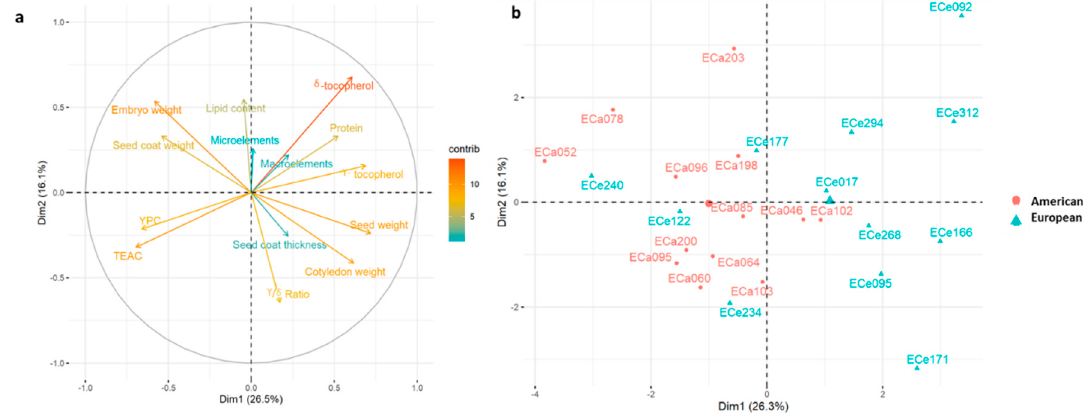
Figure 5. ( a ) Principal component analysis for the 25 American and European accessions based on morphological seed traits (seed, cotyledon, embryo, coat weights), nutritional quality traits (lipid, γ -tocopherol, δ -tocopherol, total tocopherols, YPC, protein contents; TEAC), and macro-element and micro-element contents (sums of Fe, Zn, Mn, Cu, Se, Mo, Ni contents and Na, Mg, P, K, Ca contents); ( b ) loading plot from the principal component analysis. Positive correlated variables point to the same side of the plot, negative to opposite sides. Color gradient (from red to blue) indicates contribution of each variable to each dimension. A, American accessions; E, European accessions.